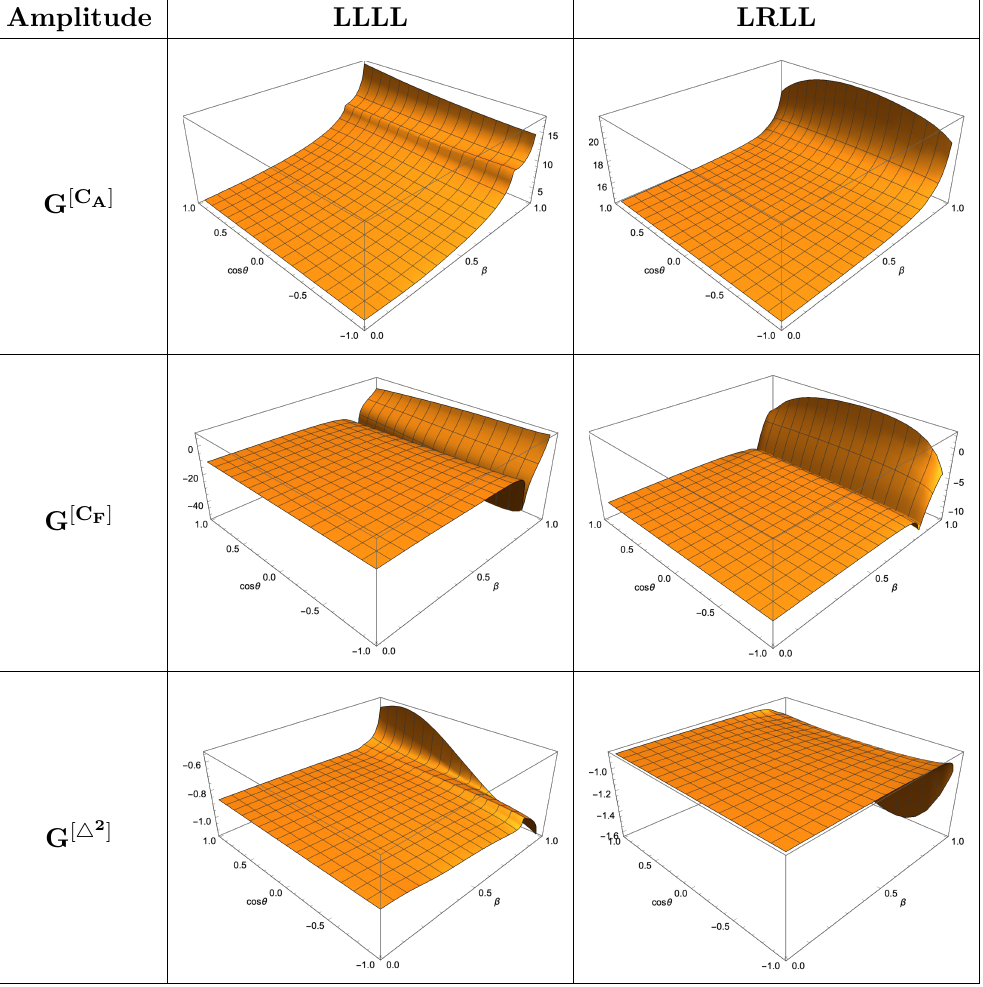
Table 3. Interference of the finite remainders of the two-loop amplitude and the leading order amplitude as functions of β and cos θ . See eqs. (4.6) and (4.7) for details. The renormalisation scale is set to µ = m Z = 91